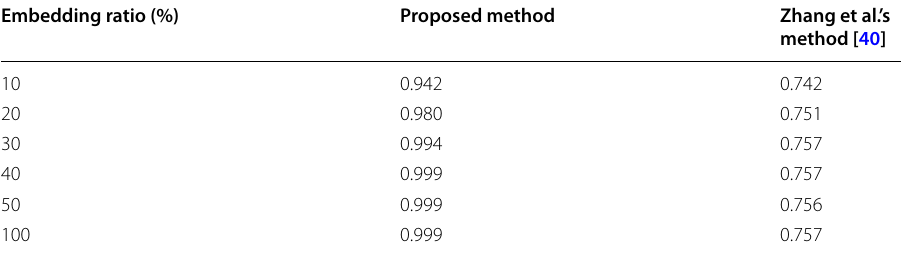
Table 5 Comparison of the accuracy of methods for the BOSS image database Embedding ratio (%)